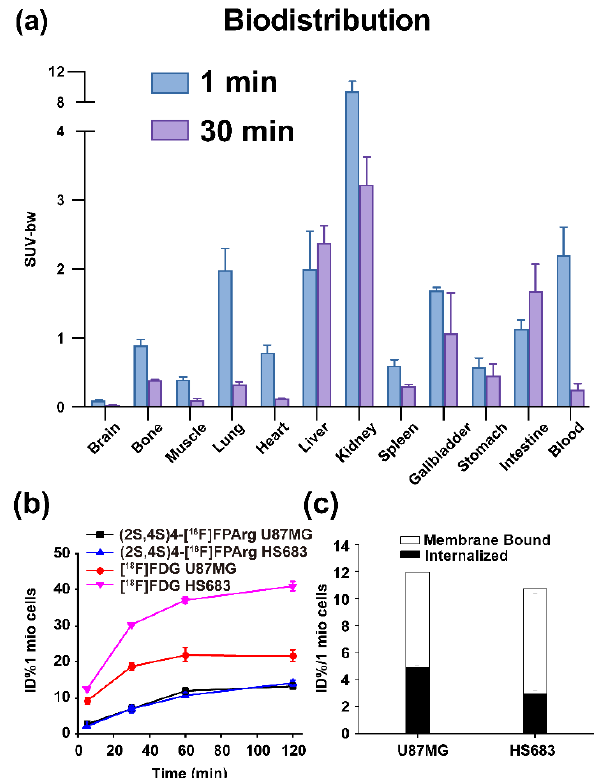
Figure 2. ( a ) In vivo biodistribution of (2S,4S)4 – [ 18 F]FPArg in BALB/c mouse ( n = 4); Cell